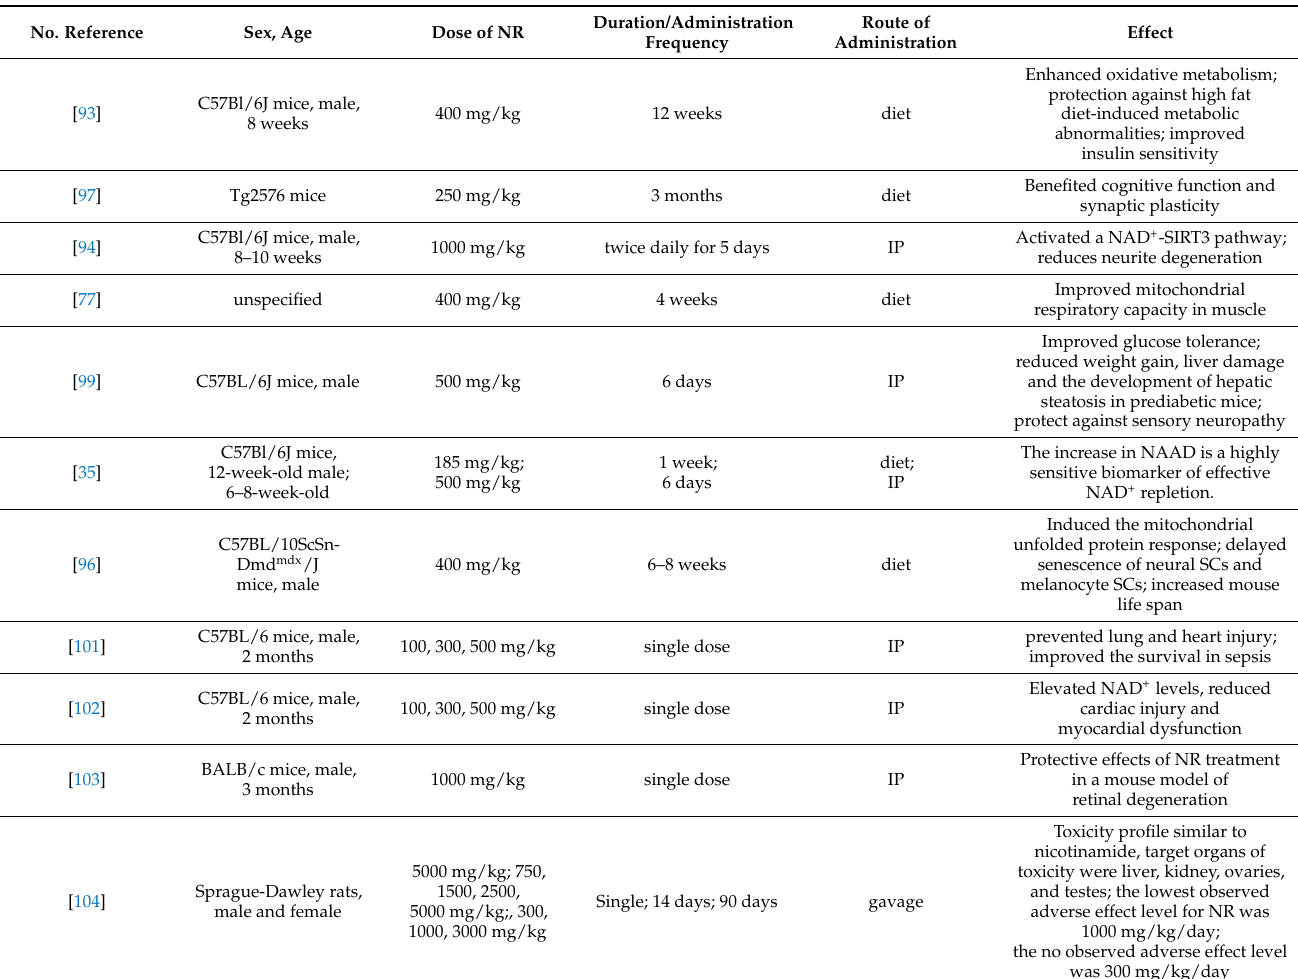
Table 1. Effects of NR on small laboratory animal